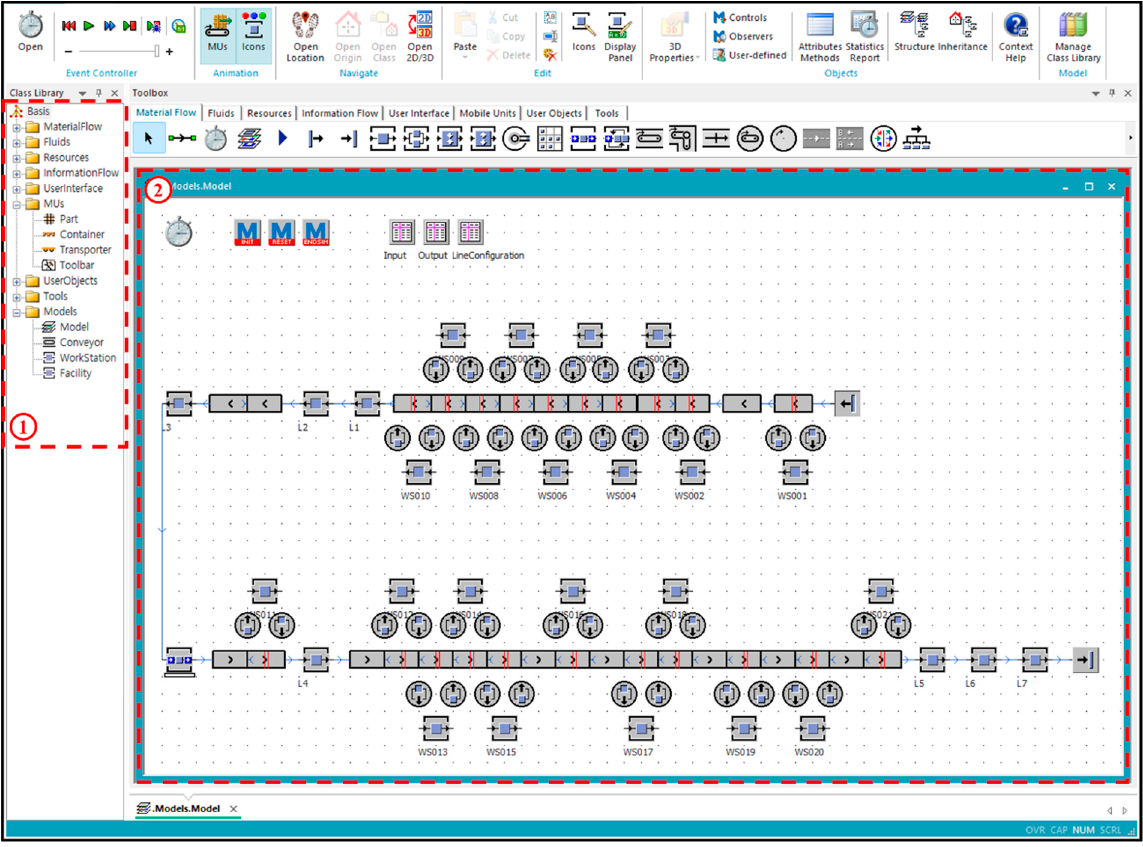
Figure 4. Example of the implemented DT simulation module and simulation